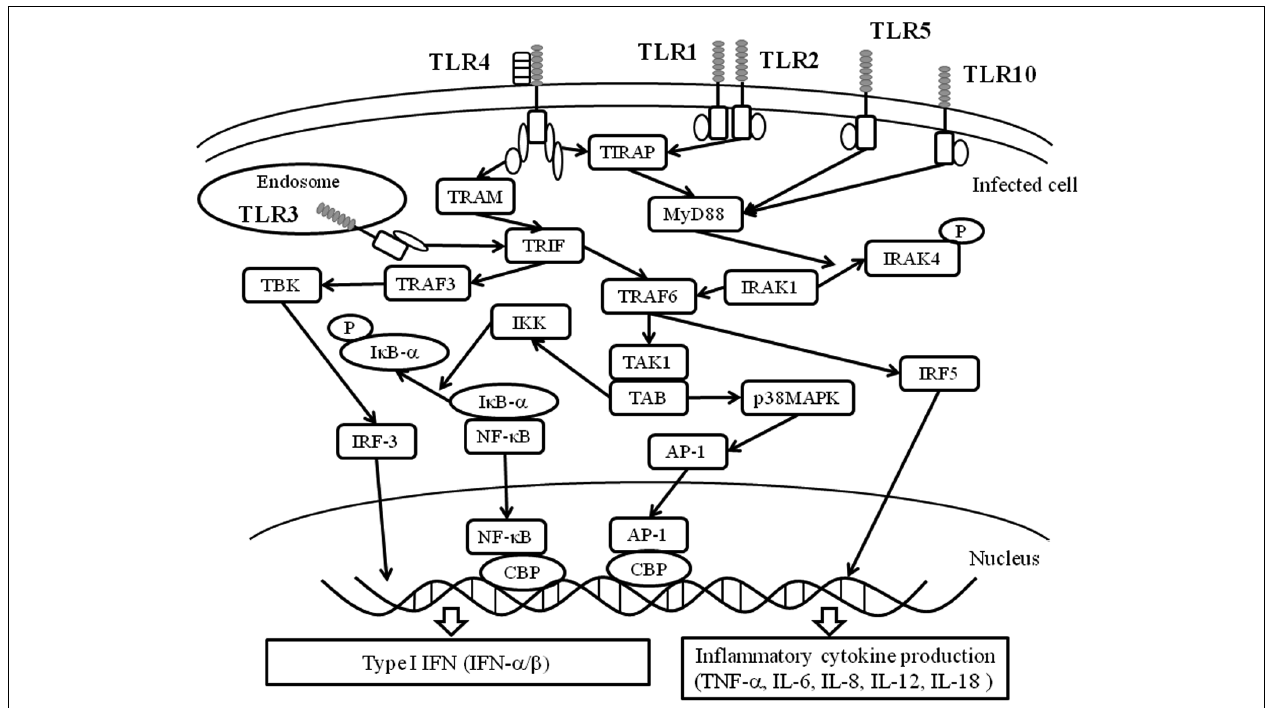
FIGURE 3 | EssentialTLR-associated signaling pathways and cytokine production. Upon ligand stimulation, allTLRs, exceptTLR3, recruit the adaptor MyD88. In turn, MyD88 binds to a protein complex composed of IRAK4, IRAK1, andTRAF6.TRAF6 undergoes self-polyubiquitination resulting in the phosphorylation ofTAK1. In turn,TAK1 activates IKK complex that leads to the phosphorylation, ubiquitination, and degradation of I κ B α .This allows NF- κ B to translocate into the nucleus. Simultaneously, theTAK1-containing complex activates the p38 MAP kinase pathway triggering the activation of AP-1.Together, NF- κ B and AP-1 induce the expression of pro-inflammatory cytokines.TLR4 andTLR2, in combination withTLR1 orTLR6, recruitTIRAP that serves as a link adaptor for the recruitment of MyD88. Moreover,TLR4 recruits a second link adaptor namedTRAM that allows interaction with the